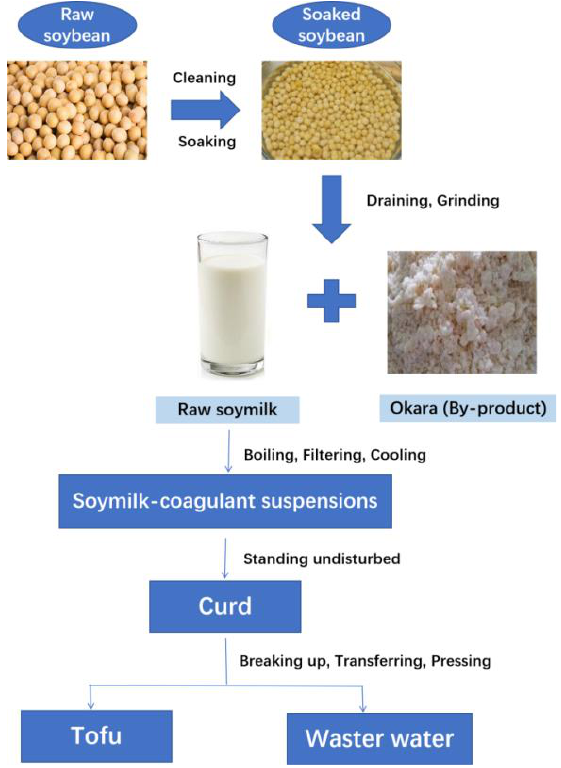
Figure 1. Schematic flow chart of the production of tofu from soybeans.